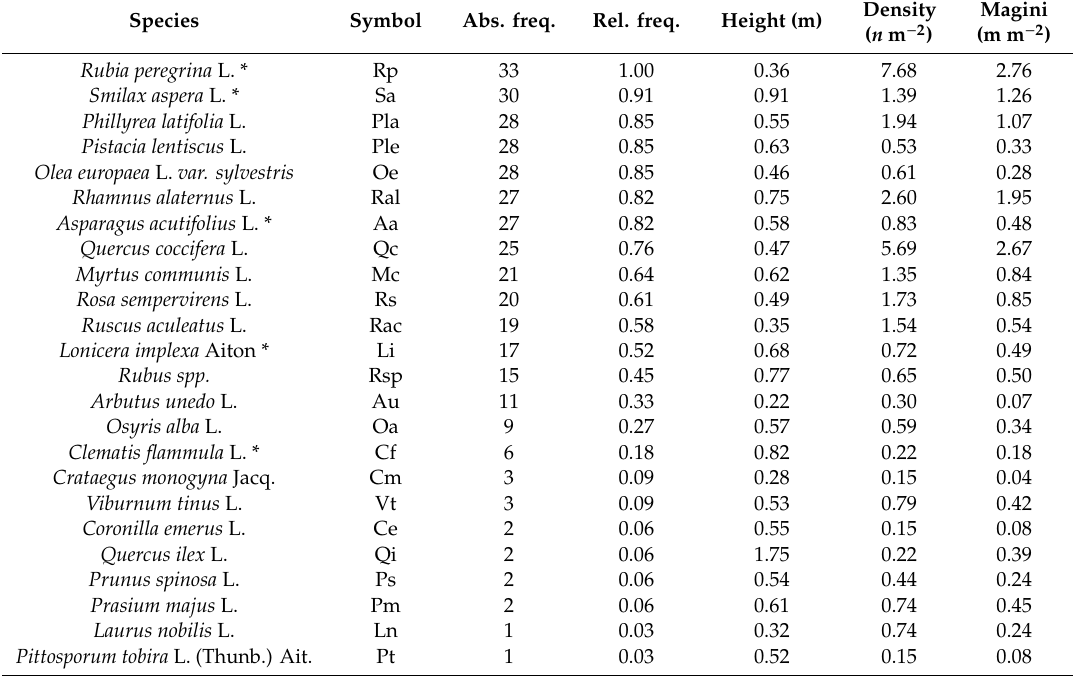
Table 2. List of the 24 inventoried understory species, ranked by decreasing order of their frequency. The table presents the species names and respective symbols, the absolute number of plots where they occurred, relative frequencies, Plant Height, Plant Density (only considering the plots where the species occurred), and the Magini index calculated by species. Species Symbol Abs. freq. Rel. freq. Height (m)